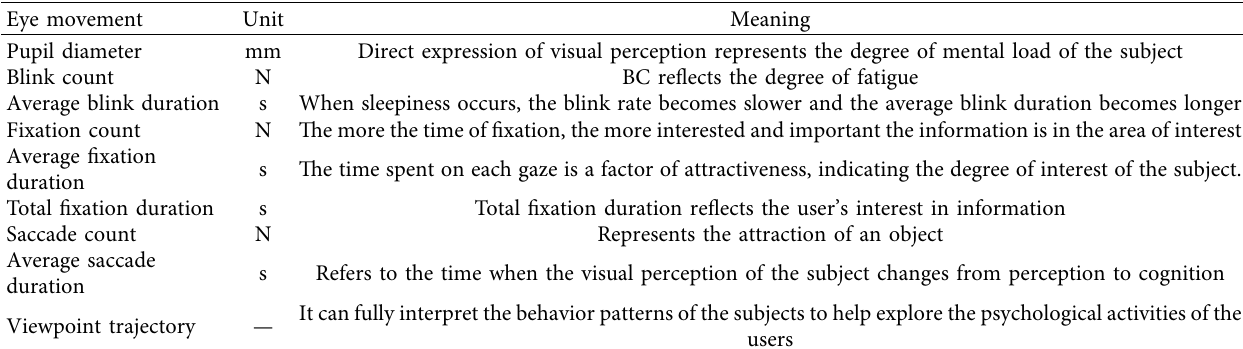
Table 2: Experiment index.